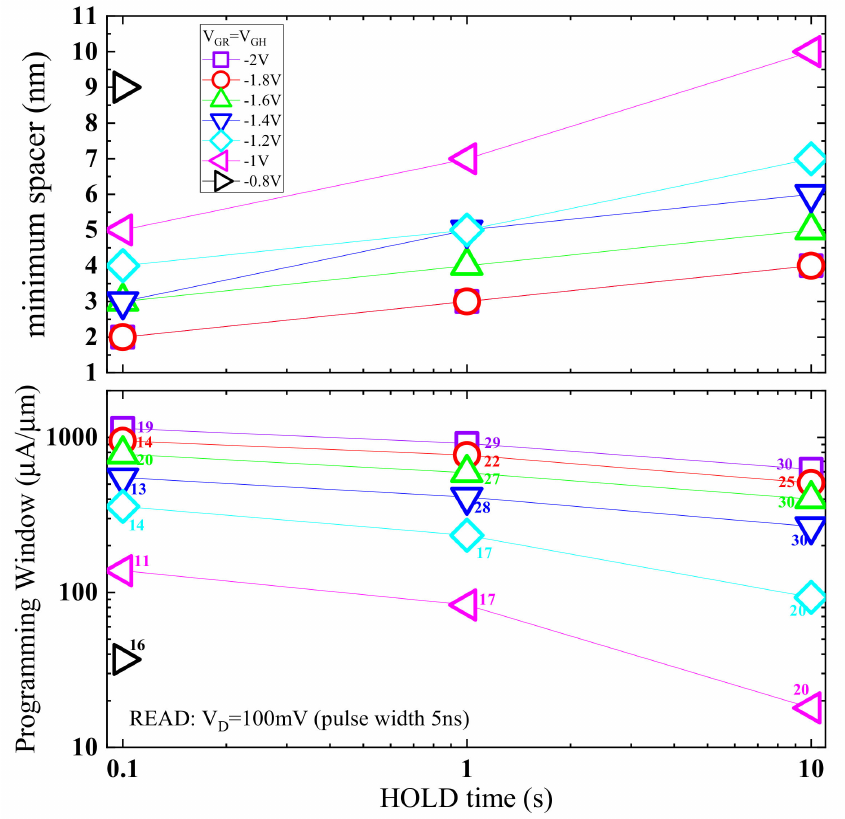
Figure 11. ( Top ) Minimum spacer length in order to meet ITRS requirements as function of t HOLD and V G,READ = V G,HOLD ; ( Bottom ) the corresponding programming window (close to each symbol the corresponding value of the optimum WR). The observation spaces for L SP and WR are limited to 10 nm and 50 nm, respectively, with 1 nm